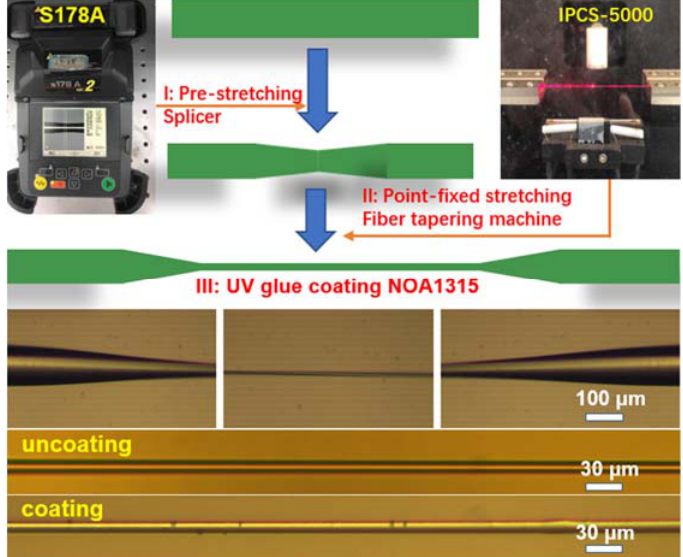
Figure 1. Schematic diagram of fabrication process of NPs-coated microfiber using two-steps point- fixed stretching method.